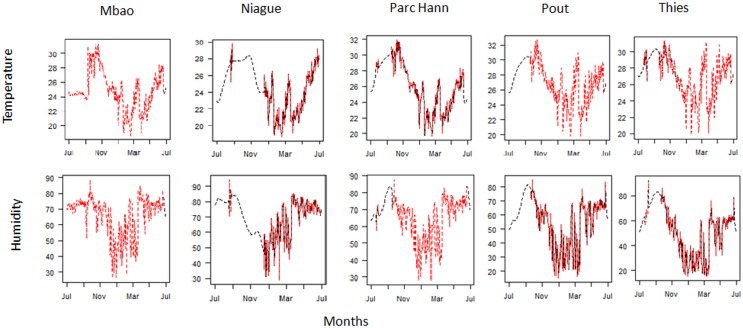
Gap filing data using Multivariate Singular Spectrum Analysis (MSSA).Estimating temperature and relative humidity missing data using MSSA method in each study site. In red the recorded environmental quantities, in black the reconstructed environmental quantities using MSSA method.